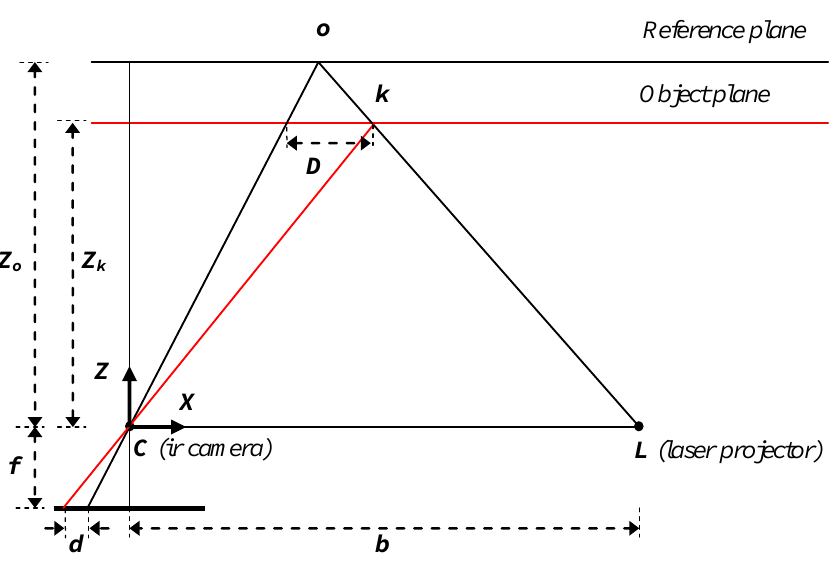
Figure 2. Relation between relative depth and measured